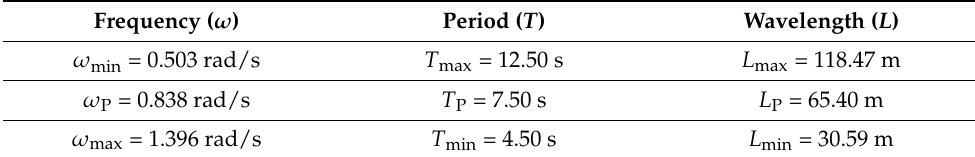
Table 4. Wave characteristics